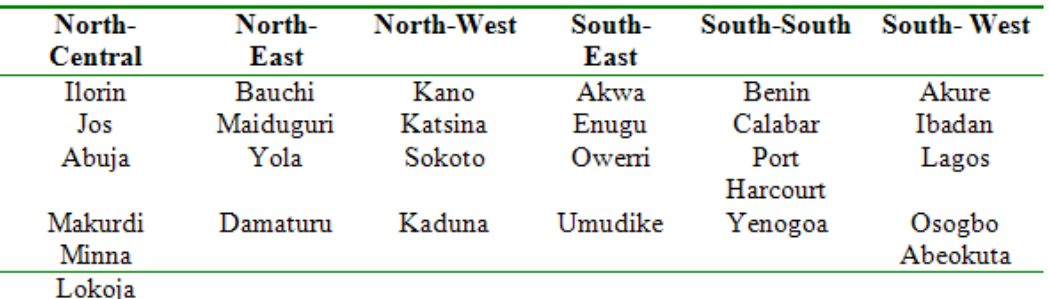
Table 4. Regional Distribution of NOUN Study